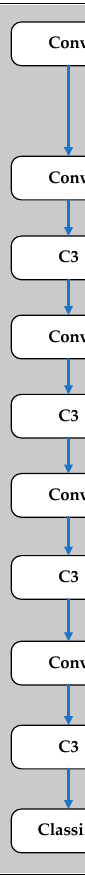
Figure 10. Backbone structure of Yolov5m model.